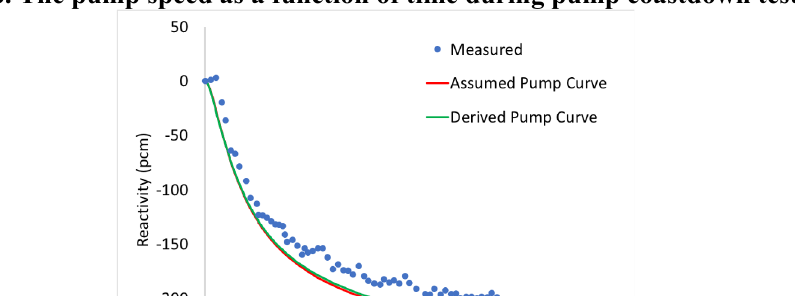
Figure 6. The pump speed as a function of time during pump coastdown test [7].